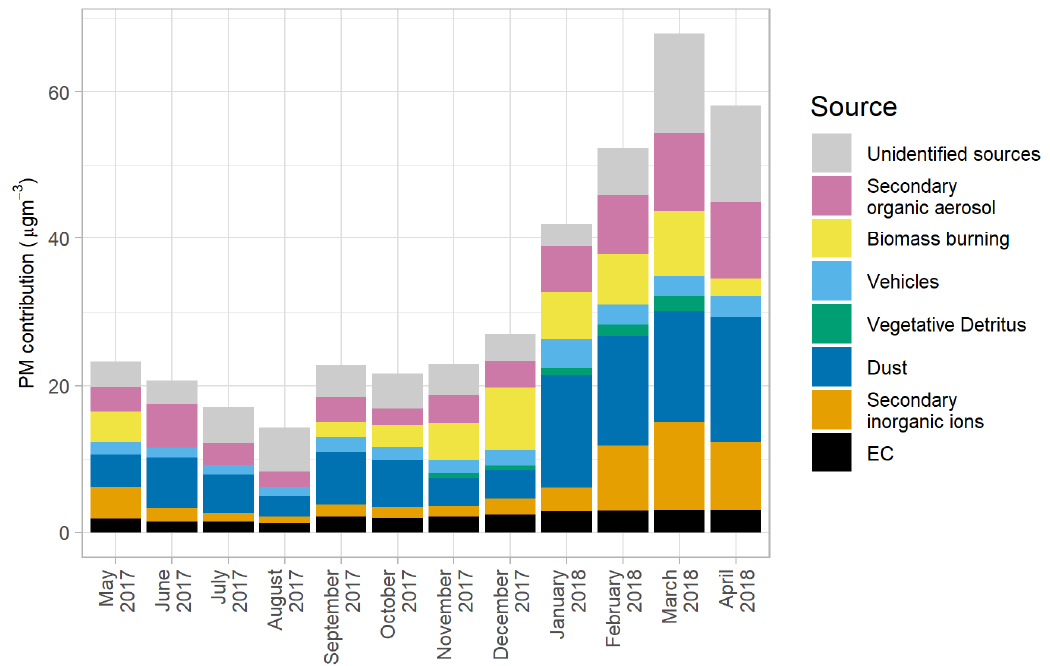
Figure 9. Monthly source contribution to PM 10 mass estimated using the CMB model in Yangon, Myanmar.